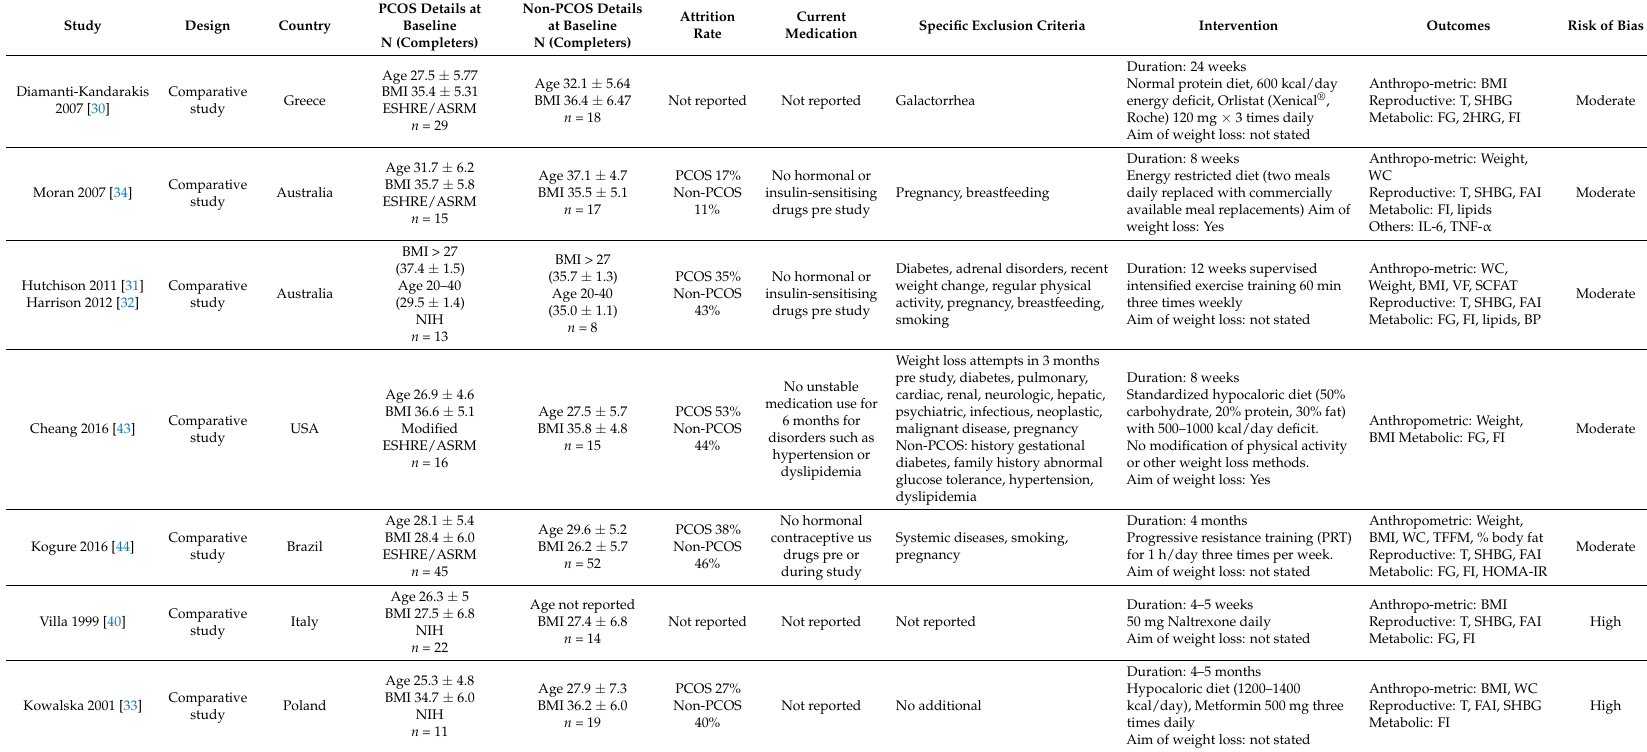
Table 1. Characteristics of included